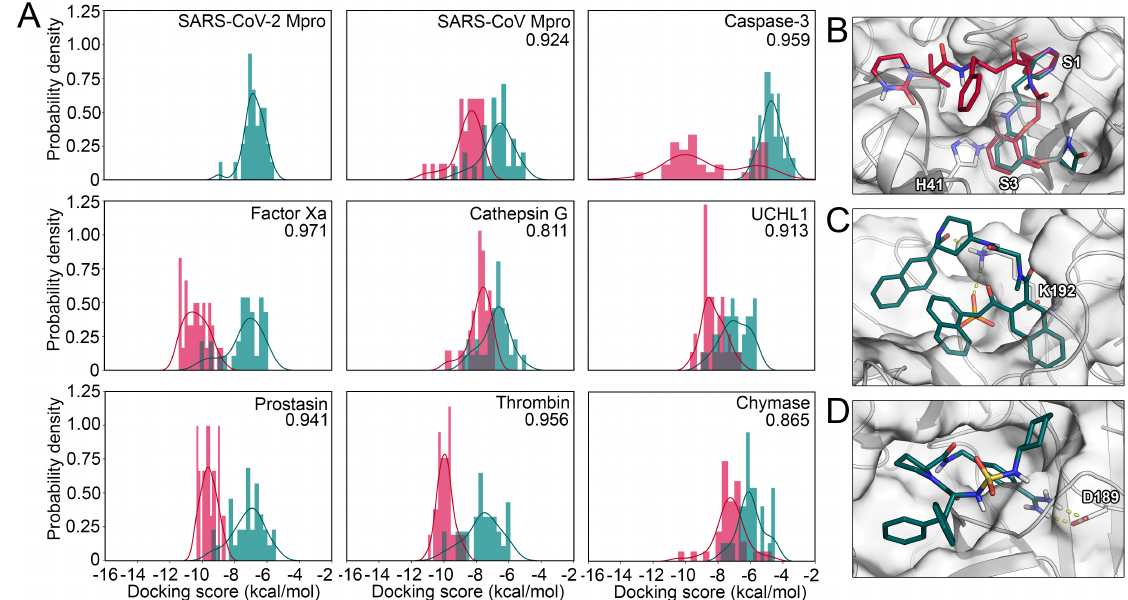
Figure 4. ( A ) Score distribution of SARS-CoV-2 M pro inhibitors docked to the selected panel of proteases. The compounds designed against SARS-CoV-2 M pro are shown in pine green, while the known actives for the remaining targets are shown in red. ROC AUC values with the SARS-CoV-2 M pro inhibitors regarded as decoys for every target are shown. ( B ) Binding mode of compound 32 (red) and compound 14 (pine green) toward SARS-CoV-2 M pro . ( C ) Binding mode of compound 199 toward cathepsin G. ( D ) Binding mode of compound 177 toward thrombin.